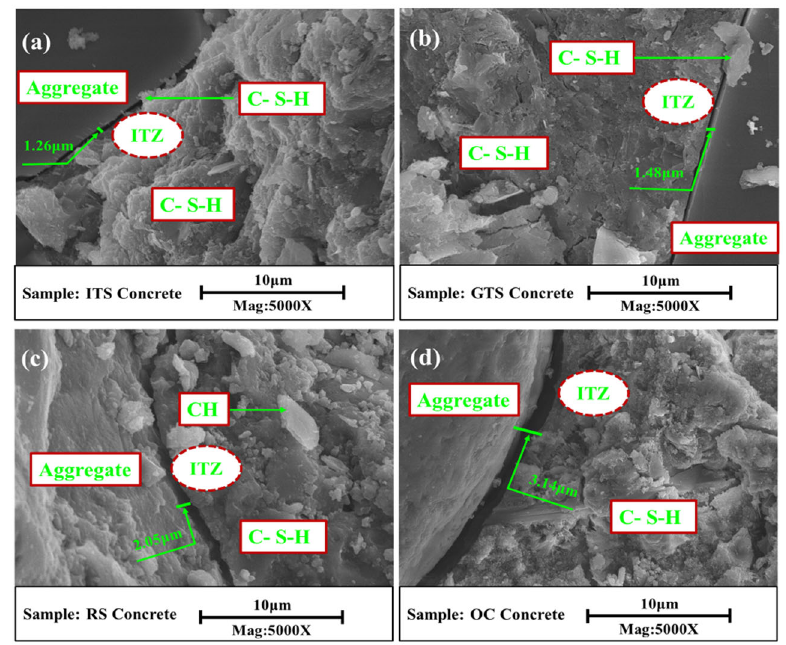
Figure 11. ITZ of concrete ( a ) ITS sand concrete, ( b ) GTS sand concrete, ( c ) RS sand concrete, ( d ) Ordinary concrete.